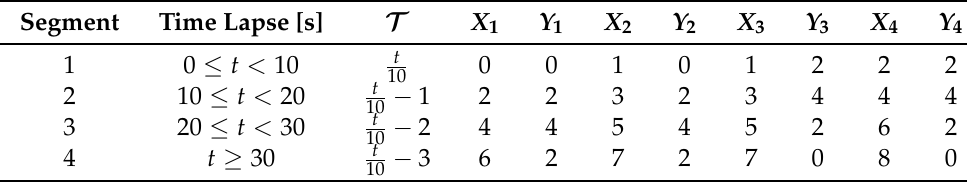
Table 2. Control and endpoint values for the Bézier curves.